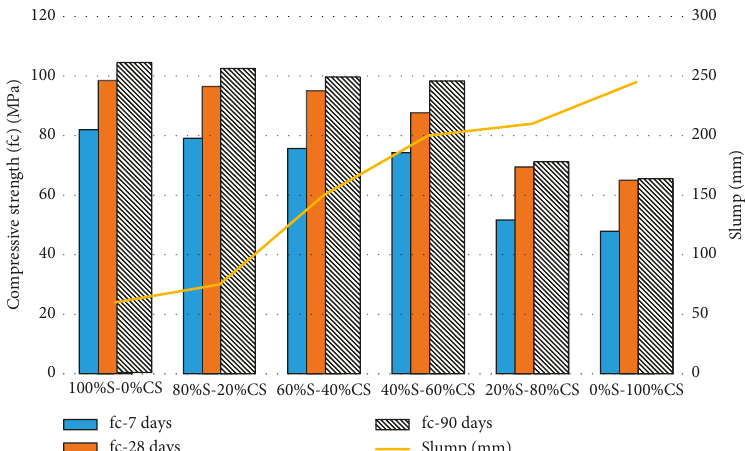
Figure 1: Workability and average strength test results of copper slag concrete mixes at different curing ages (adapted from Wu et al.